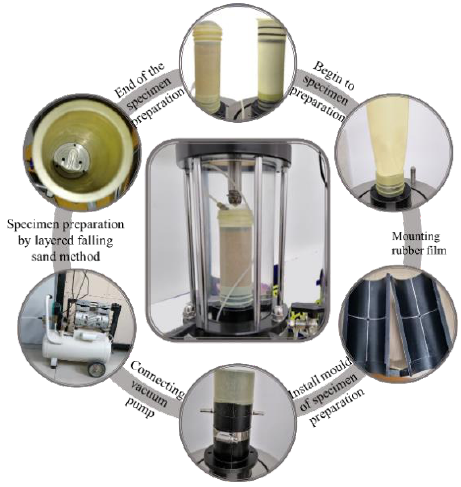
Figure 3. Specimen preparation and specimen installation.